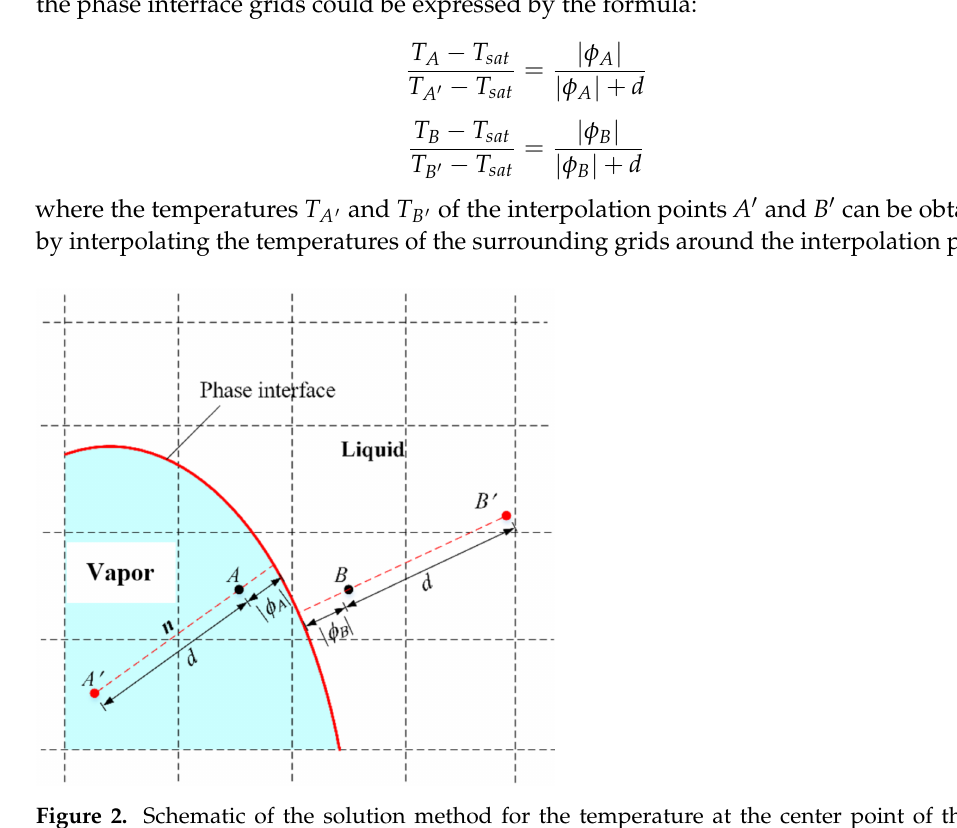
Figure 2. Schematic of the solution method for the temperature at the center point of the cell containing the phase